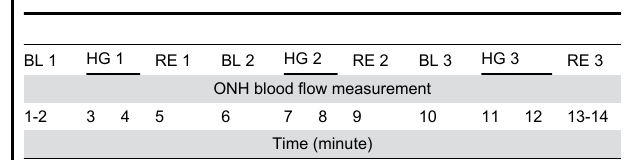
Table 1. Experimental